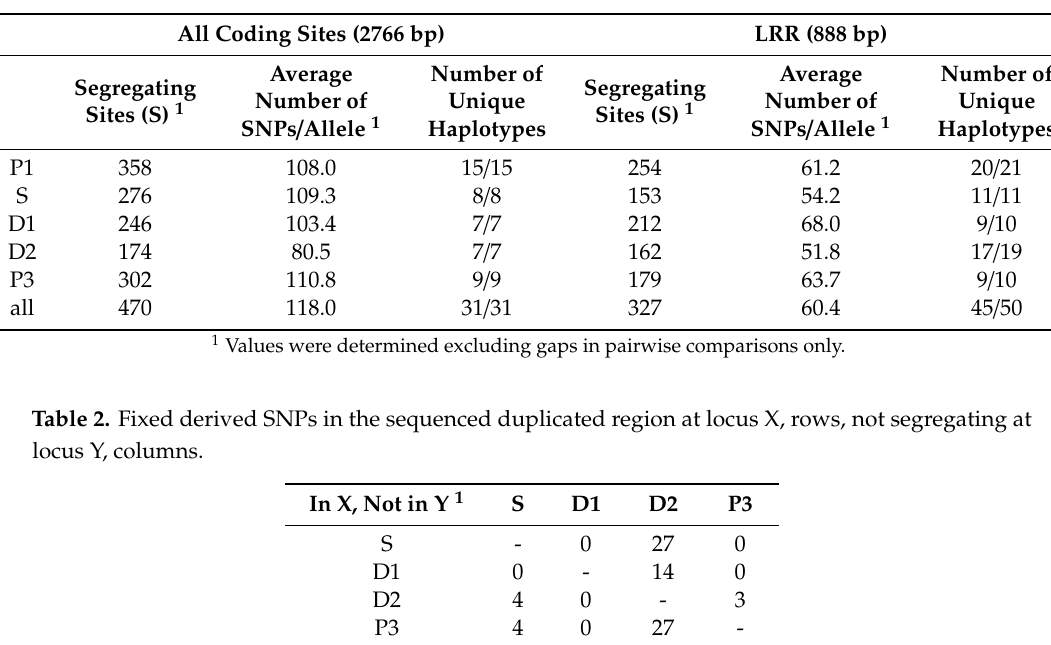
Table 1. Polymorphism within the coding and leucine-rich repeat region (LRR) of RPP8 paralogs.